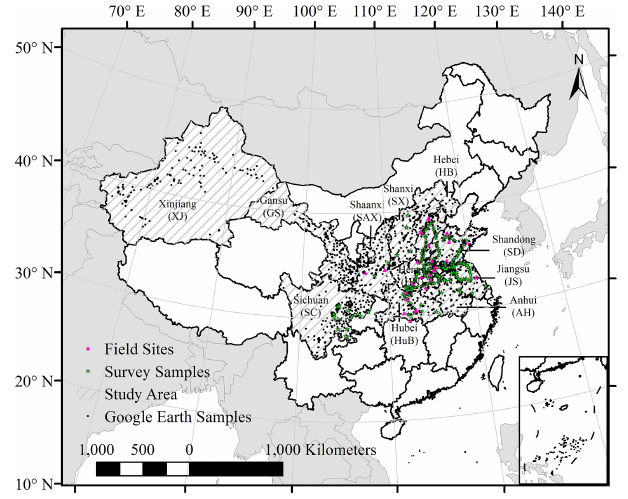
Figure 1. Study area spans 11 provinces over China (the re- gion covered by oblique lines). The solid black lines represent the boundary of the provinces. The black dots indicate survey sites obtained from Google Earth; the red triangles indicate field sur- vey sites; and each site covers 1km 2 . The green five-pointed stars show field survey samples. Provincial administrative boundary data and global country administrative boundary data are sourced from http://www.resdc.cn/DOI/ (last access: 1 December 2019) © Insti- tute of Geographic Sciences and Natural Resources Research, Chi- nese Academy